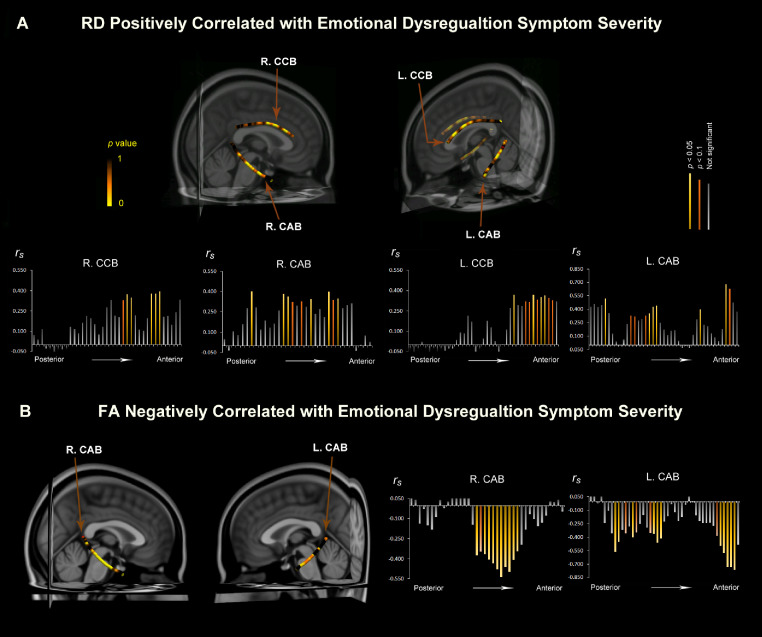
Tract-based results of significant regions where diffusivities significantly correlate with ED. Post-hoc examinations along tracts of interest show significant locations of positive correlations between RD and ED (yellow color in brain images in 4A) and negative correlations between FA and ED (4B) along the bilateral cingulum bundles (P < 0.05; dorsal bundle = cingulum cingulate bundle, CCB; ventral bundle = cingulum angular bundle, CAB). The bar graphs visualize the strength of the correlations (Y-axis, Spearmans’ correlation coefficient) along each tract's spline point (X-axis).